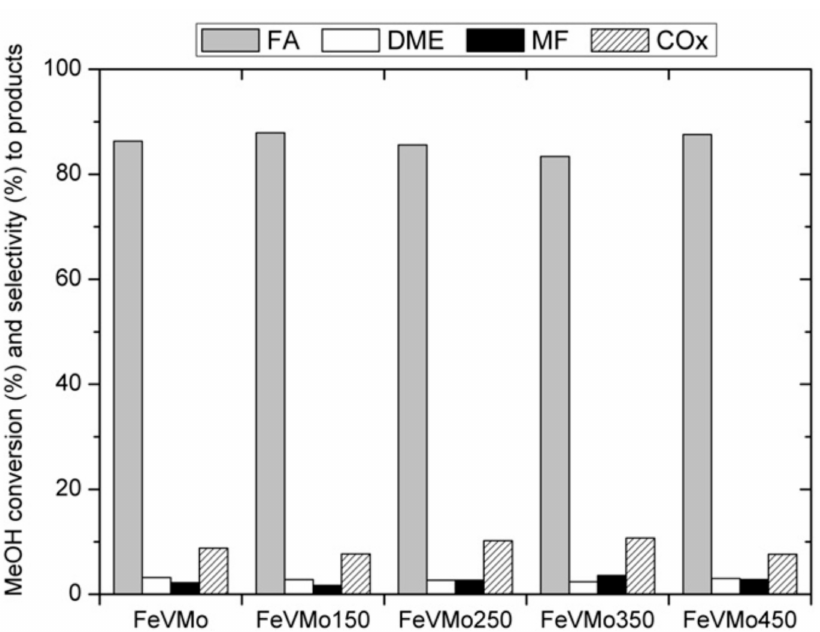
Figure 38. Selectivities to formaldehyde (FA), dimethyl ether (DME), methyl formate (MF), and carbon oxides over Fe-V-Mo-O spinel-type catalyst preoxidized up to different temperatures in the temperature programmed oxidation. The selectivities are taken after 16 h at a steady-state at 300 ◦ C with a feed flow of 100 mL/min of 10 vol.% MeOH and 10 vol.% O 2 in N 2 . The conversions were in the range of 82–88%. Reprinted from [215] Copyright © (2011), with permission from Elsevier. Different vanadates (AlVO 4 , Co 3 (VO 4 ) 2 , FeVO 4 , Mg 3 (VO 4 ) 2 , Mn 3 (VO 4 ) 2 , Ni 3 (VO 4 ) 2 , and Zn 3 (VO 4 ) 2 ) were investigated by Andersson et al. [6] and compared against the commercial Formox KH44L catalyst at 300 ◦ C with 6 vol.% MeOH and 11 vol.% O 2 in inert gas (Figure 39).